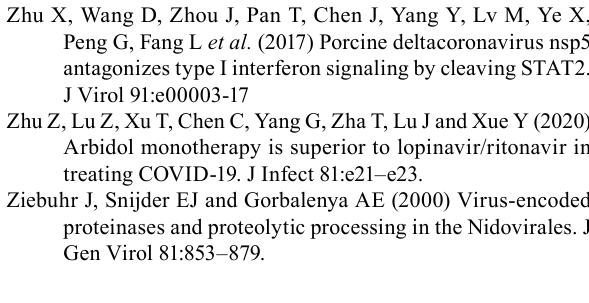
Figure S2 – Activation of IRF by cytosolic pattern recognition receptors. Figure S3 – Cell cycle: G1/S checkpoint regulation. Figure S4 – Cyclins and cell cycle regulation. Figure S5 – Systemic lupus erythematosus in B cell signaling pathway. Figure S6 – EIF2 signaling. Figure S7 – Autophagy. Figure S8 – FAT10 signaling pathway. Figure S9 – Regulation of eIF4 and p70S6K signaling. Figure S10 – Role of p14/p19ARF in tumor